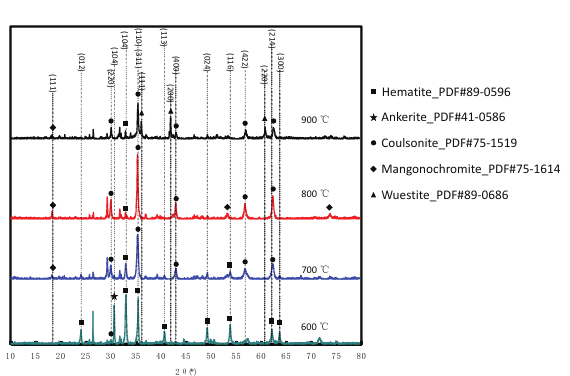
Figure 5: XRD patterns of magnetic roasting process at different temperatures.